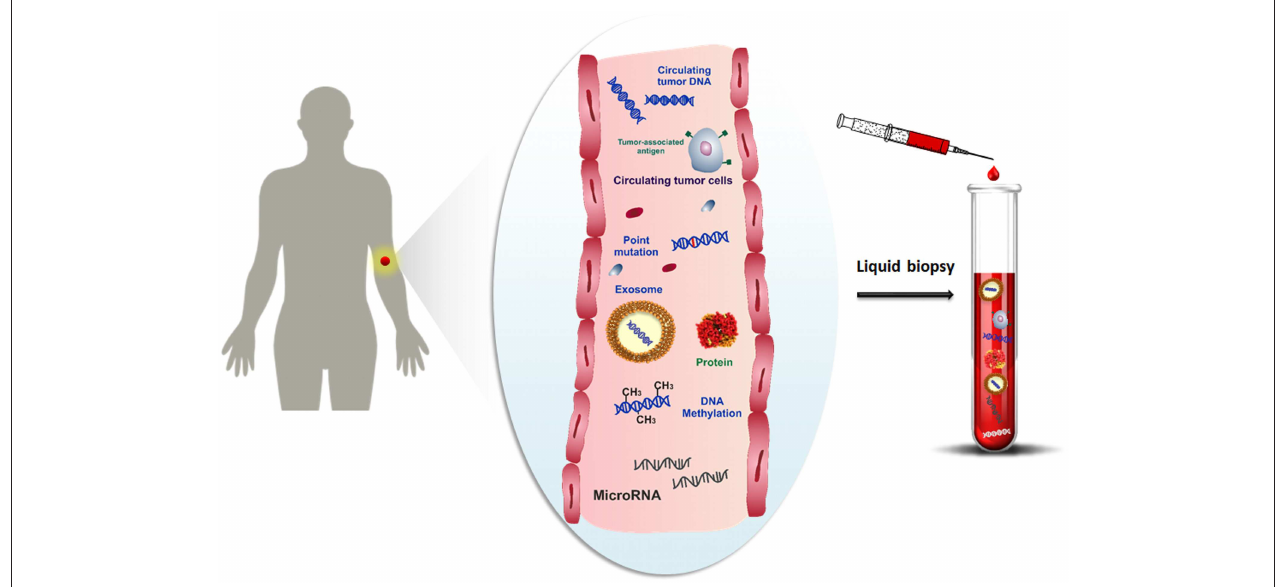
FIGURE 1 | Schematic representation of cancer-related biomolecules such as cells, proteins, nucleic acids and microvesicles circulating into the bloodstream, and collection of these biomarkers by liquid